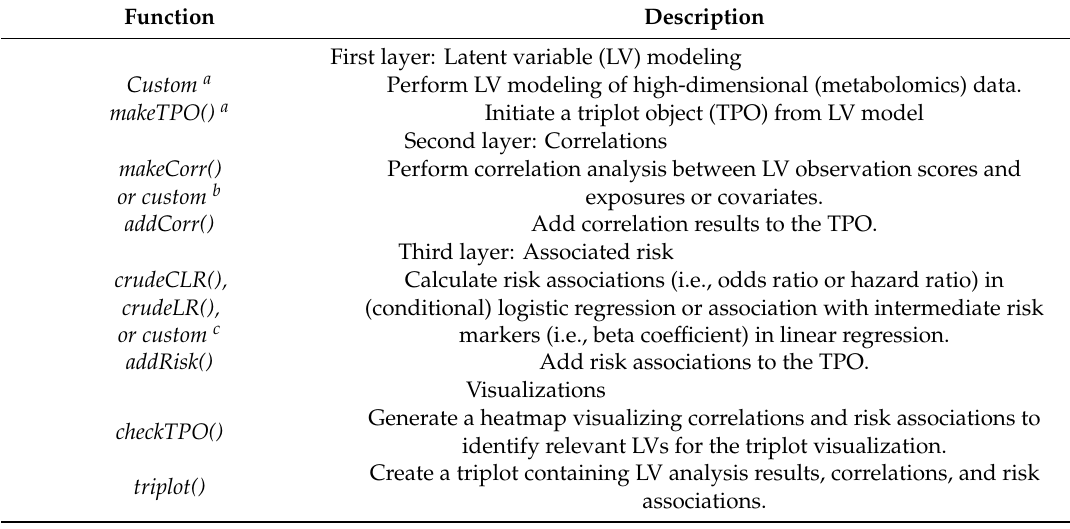
Table 1. Overview of the workflow and main functions in the ‘triplot’ R